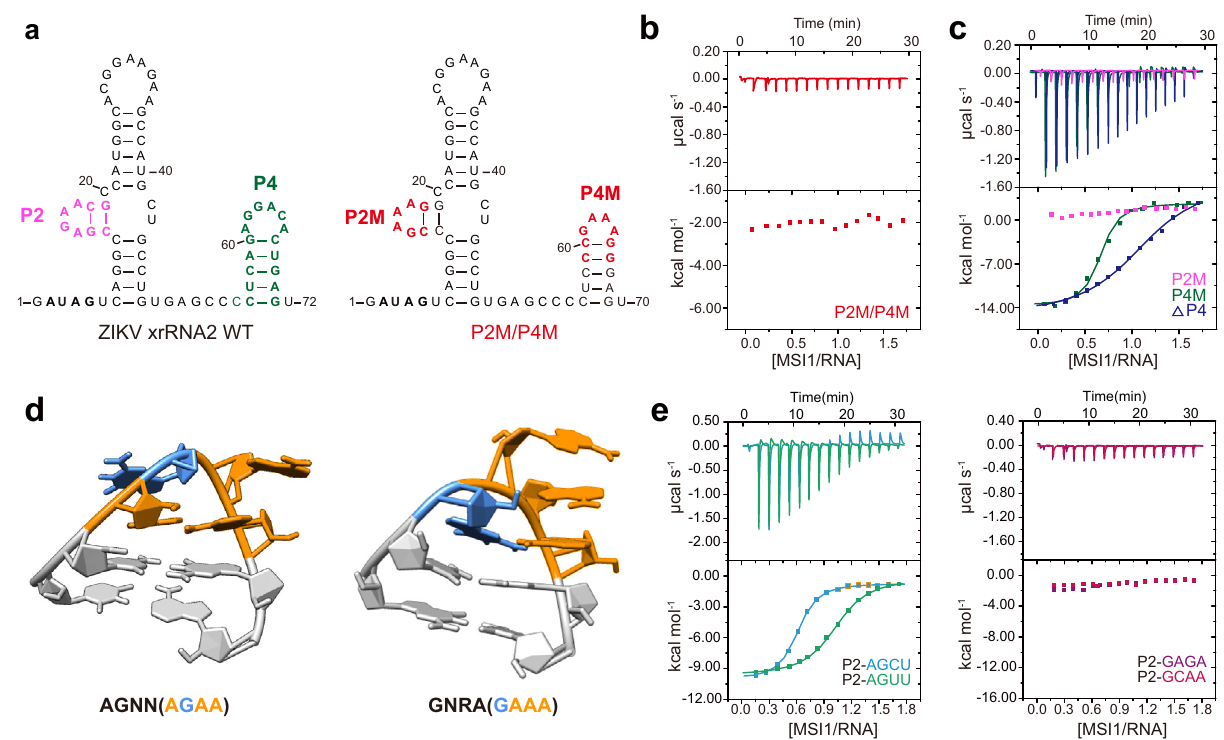
Fig. 3 | xrRNA2 P2 tetraloop fold is critical for MSI1 binding. a Secondary structure of ZIKV xrRNA2 and the xrRNA2 mutant P2M/P4M. b ITC pro fi les of RRM12 to xrRNA2 P2/P4M. c The ITC pro fi les of RRM12 to xrRNA2 mutants P2M, P4Mand △ P4. d NMRstructuresoftetraloopsofAGNNandGNRA. e ITCpro fi lesof